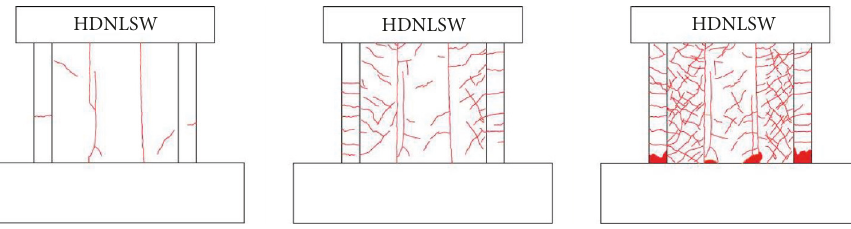
Figure 8: Crack development of the shear wall HDNLSW. Table 3: Experimental results of bearing capacity of specimens.